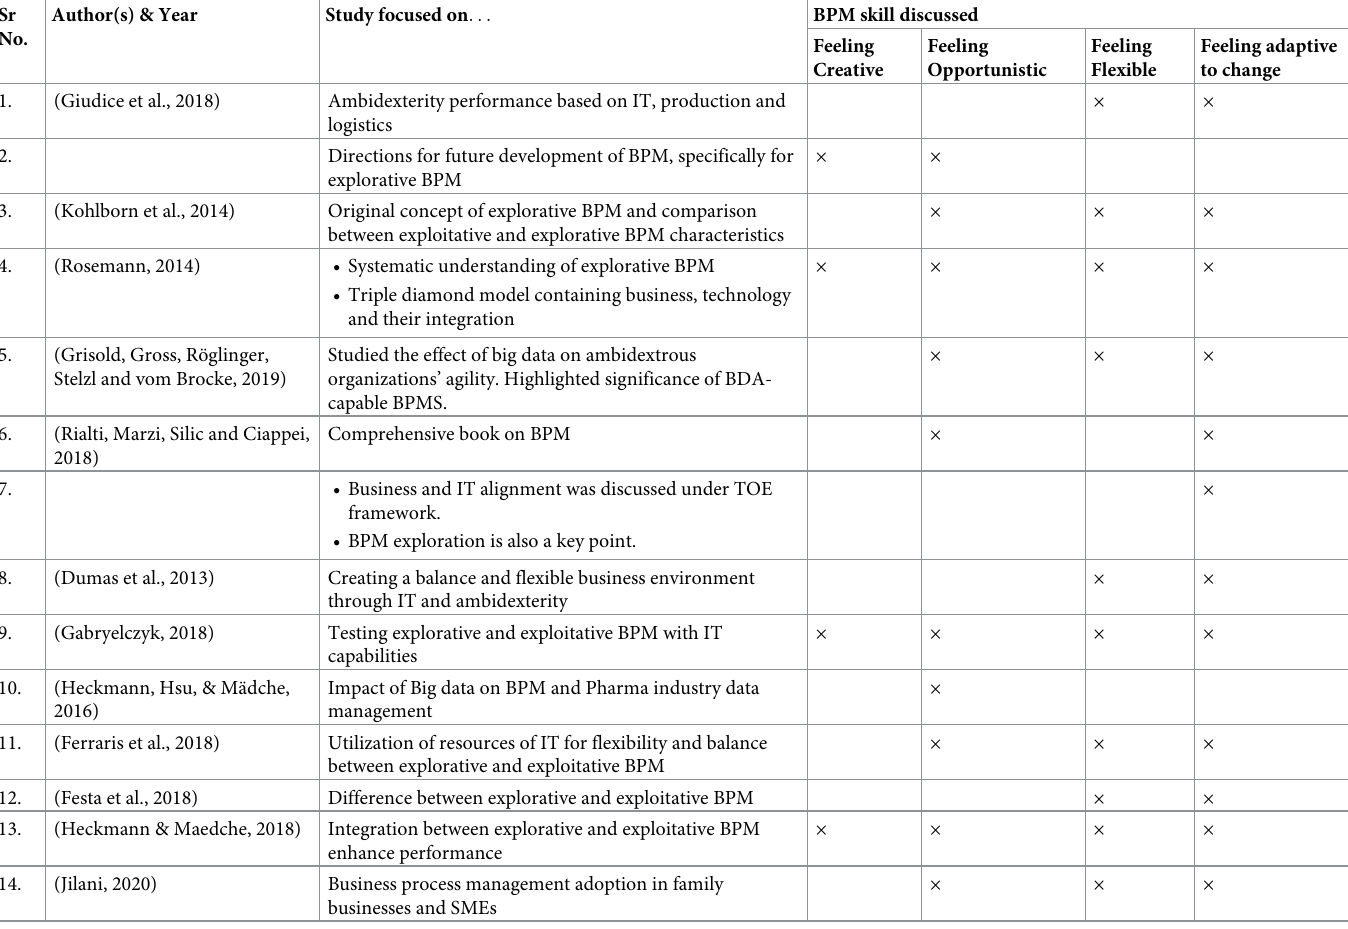
Table 1. List of articles for explorative BPM skills